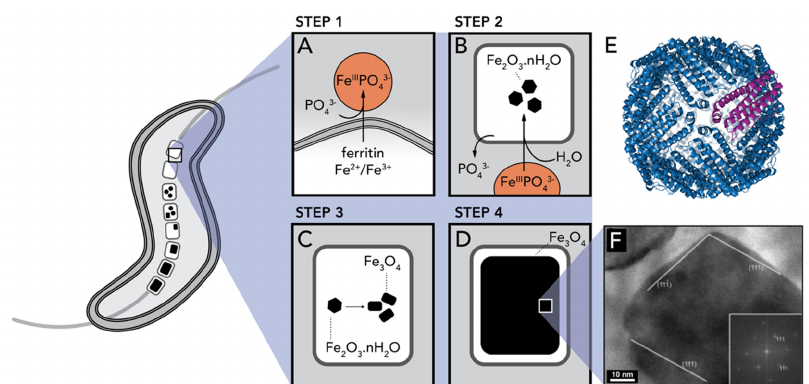
Figure 23. Model of iron uptake and magnetite formation mechanism in magnetotactic bacteria. ( A ) Step 1: Ferritin and iron ions are transported through the cytoplasmatic membrane of the bacteria and a phosphate-rich Fe III hydroxide phase is formed. ( B ) Step 2: Magnetite biomineralization starts by transport of iron ions and ferritin into the magnetosome vesicles where Fe 2+ and Fe 3+ ions coprecipitate to a ferrihydrite-like intermediate. ( C ) Step 3: Ferrihydrite is converted to magnetite, and ( D ) Step 4: it grows fully formed magnetosomes. ( E ) Ferritin protein complex. ( F ) HR-TEM image of the magnetosome from magnetotactic Gammaproteobacteria strain SS-5 . Mechanism adapted from [151] with permission from John Wiley and Sons. Image ( E ) authored by Vossmann, and reproduced under the terms of the GNU General Public License. Image ( F ) by P ó sfai, Lef è vre, Trubitsyn, Bazylinski